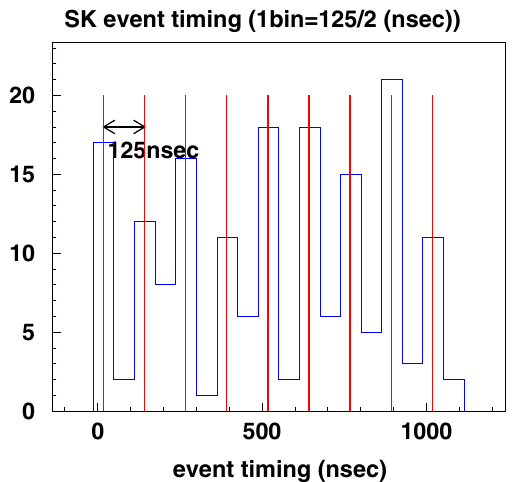
Fig. 28 Δ T distribution for fully contained events. Nine micro bunch structures caused by the beam are clearly seen